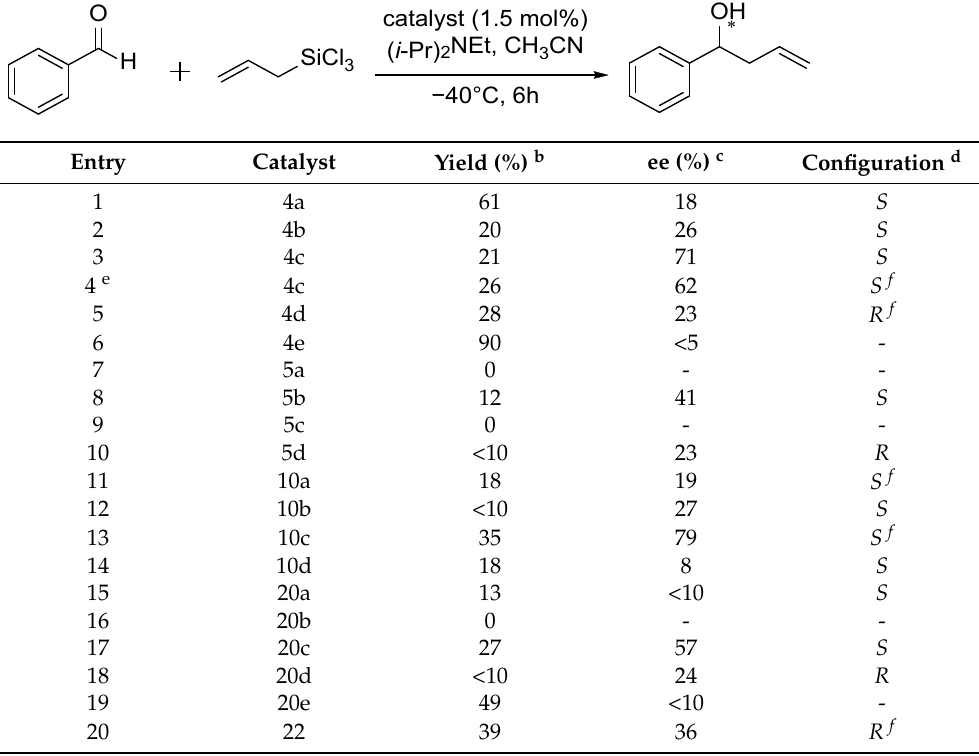
Table 1. Allylation of benzaldehyde with allyl-trichlorosilane catalyzed by obtained N-oxides. a. HO SiCl 3